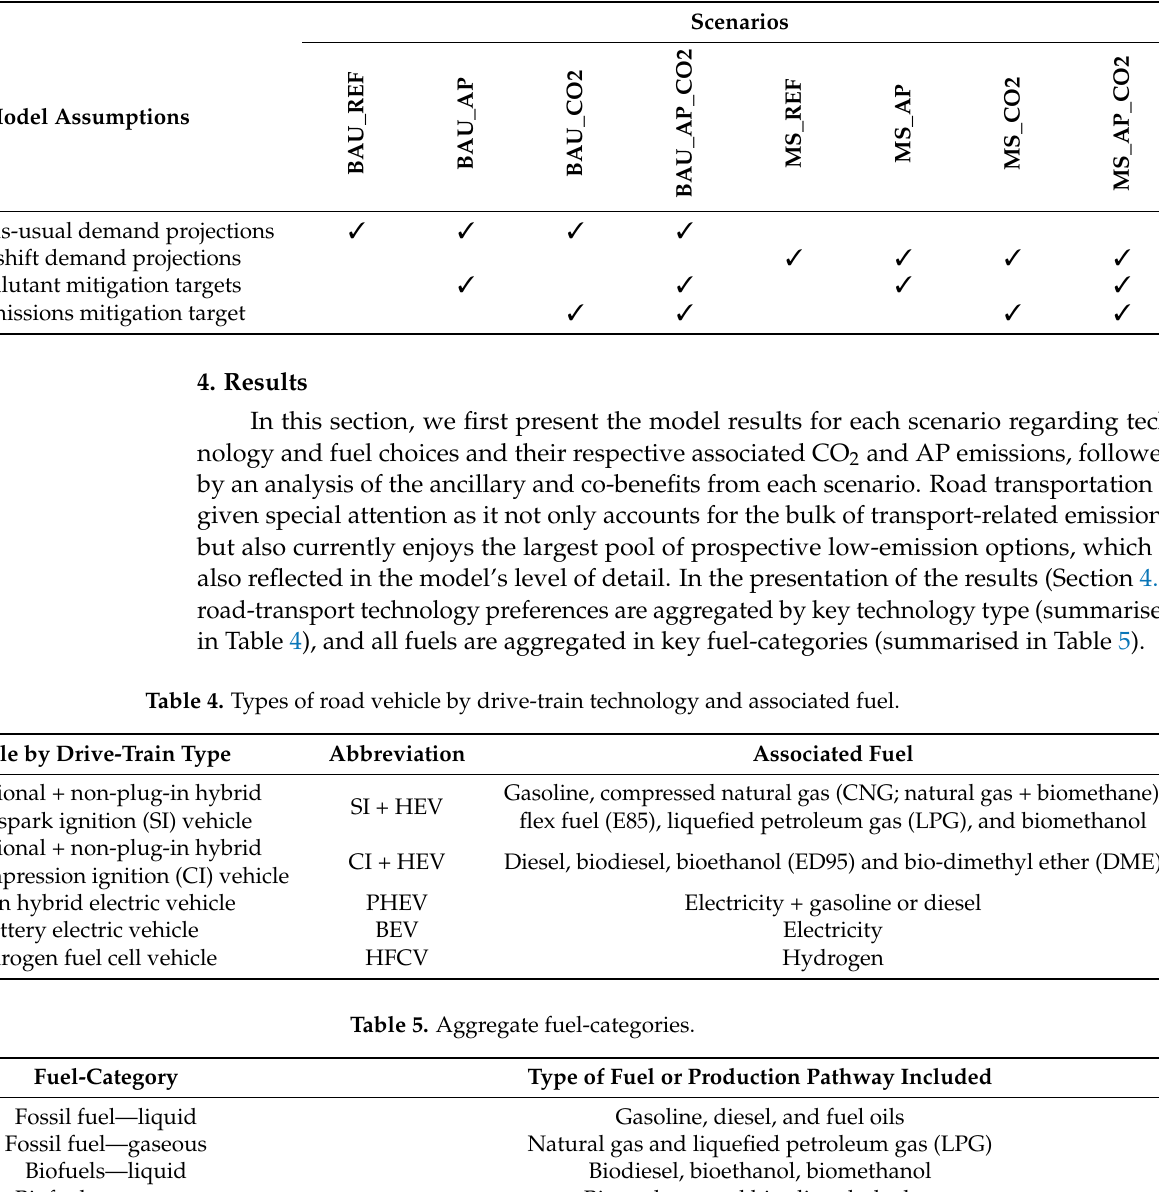
Table 3. Summary of scenario characteristics.